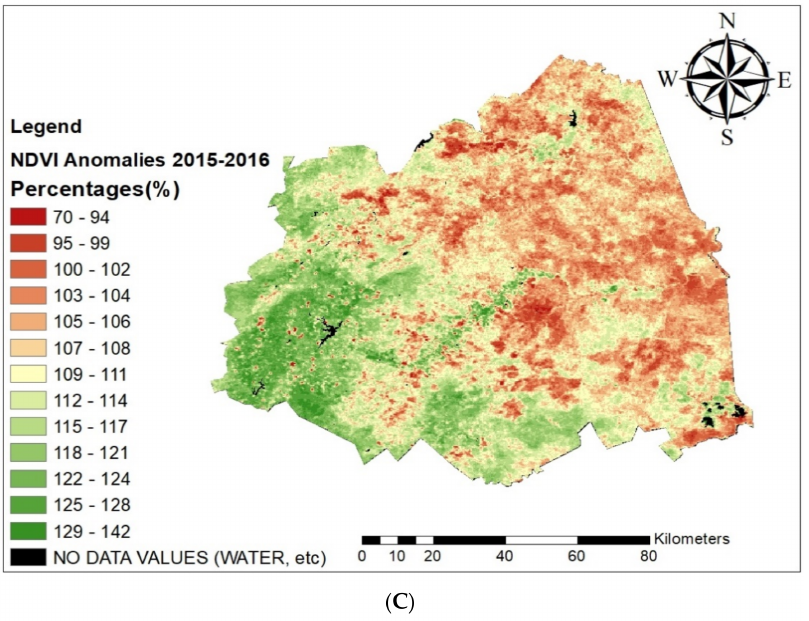
Figure 6. NDVI anomalies across Mopani District Municipality for the austral summer seasons of ( A ) 2007–2008; ( B ) 2014–2015; ( C )